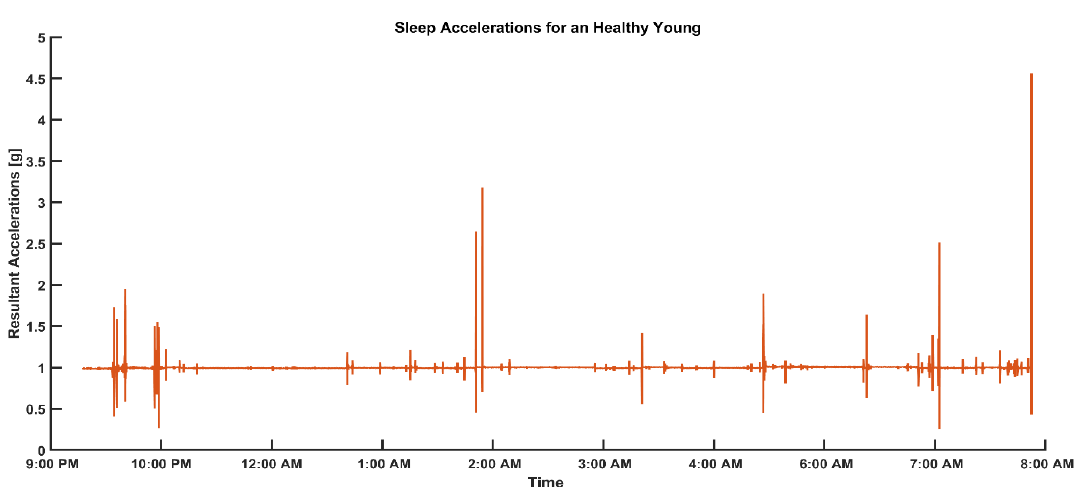
Figure 1. Representative data of resultant accelerations produced by sleep movements in healthy young adults.